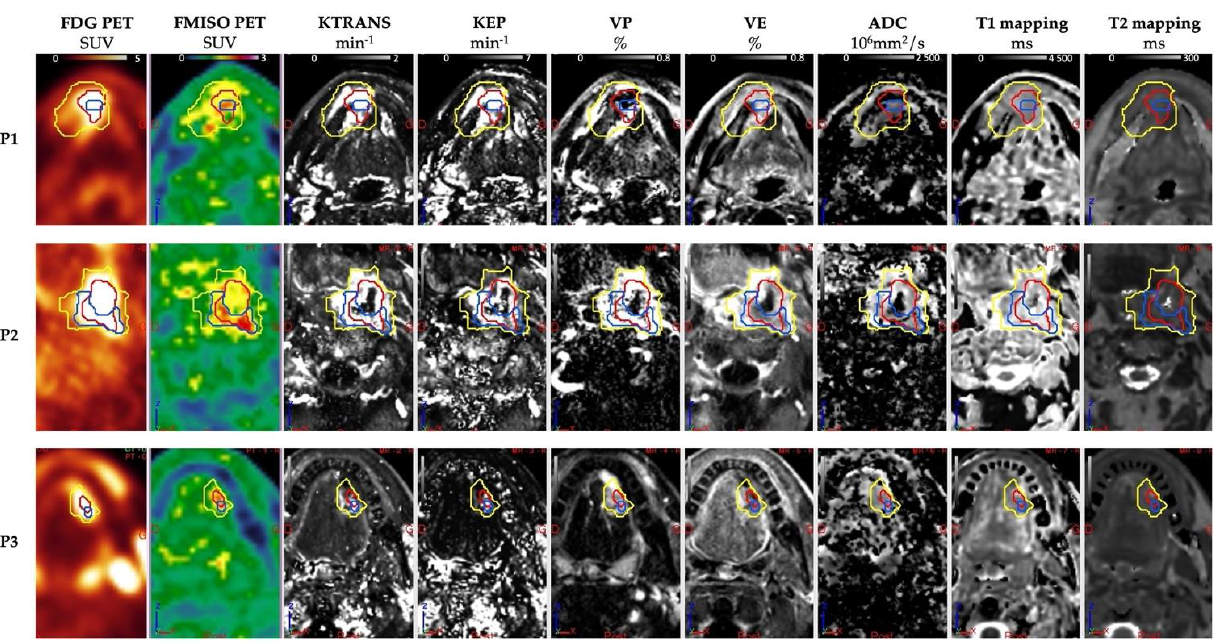
Figure 3. Wilcoxon signed-rank tests between the hypoxic sub volumes HsV_FDG (light blue), HsV_MRI (south sea blue), and HsV_MRIuFDG (dark blue).